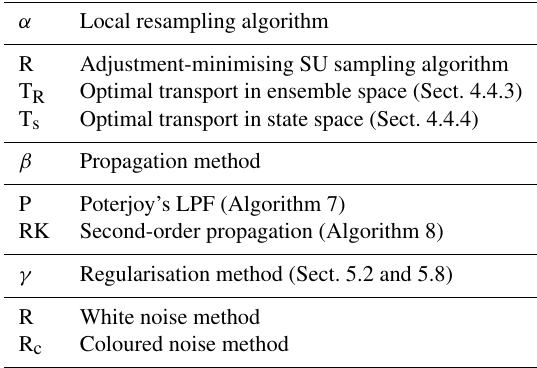
Table 3. Nomenclature conventions for the S(I α P β ) y γ algorithms. Capital letters refer to the main algorithmic ingredients: “I” for importance, “R” for resampling or regularisation, “T” for trans- port, and “P” for propagation. Subscripts are used to distinguish the methods in two different ways. Lower-case subscripts refer to explicit concepts used in the method: “s” stands for state space, “c” for colour. Upper-case subscripts refer to the work that inspired the method: “P” stands for Poterjoy (2016) and “RK” for Robert and Künsch (2017). For simplicity, some subscripts are omitted: “amsu” for adjustment-minimising stochastic universal and “w” for